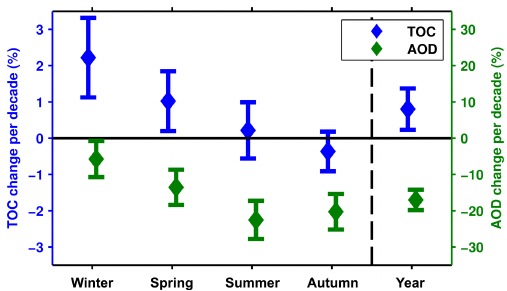
Figure 4. Long-term changes (in % per decade) and the associated 1 σ uncertainty of the seasonal and the yearly mean of TOC (blue rhombs) and the AOD at 320nm (green rhombs). The left (blue) axis corresponds to the changes in TOC while the right (green) axis to changes in